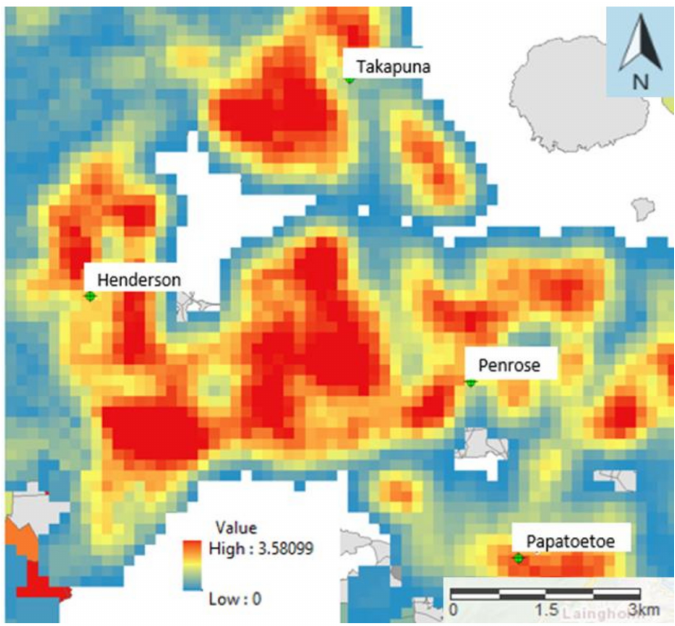
Figure 1. Map of average wood burner per hectare for each census area unit across the Auckland Region. The image has been created using the kernel Density function in ArcGIS. The Kernel density uses kernel function within GIS to fit a smoothly tapered surface to each input of burner density per Census Unit Area (Census